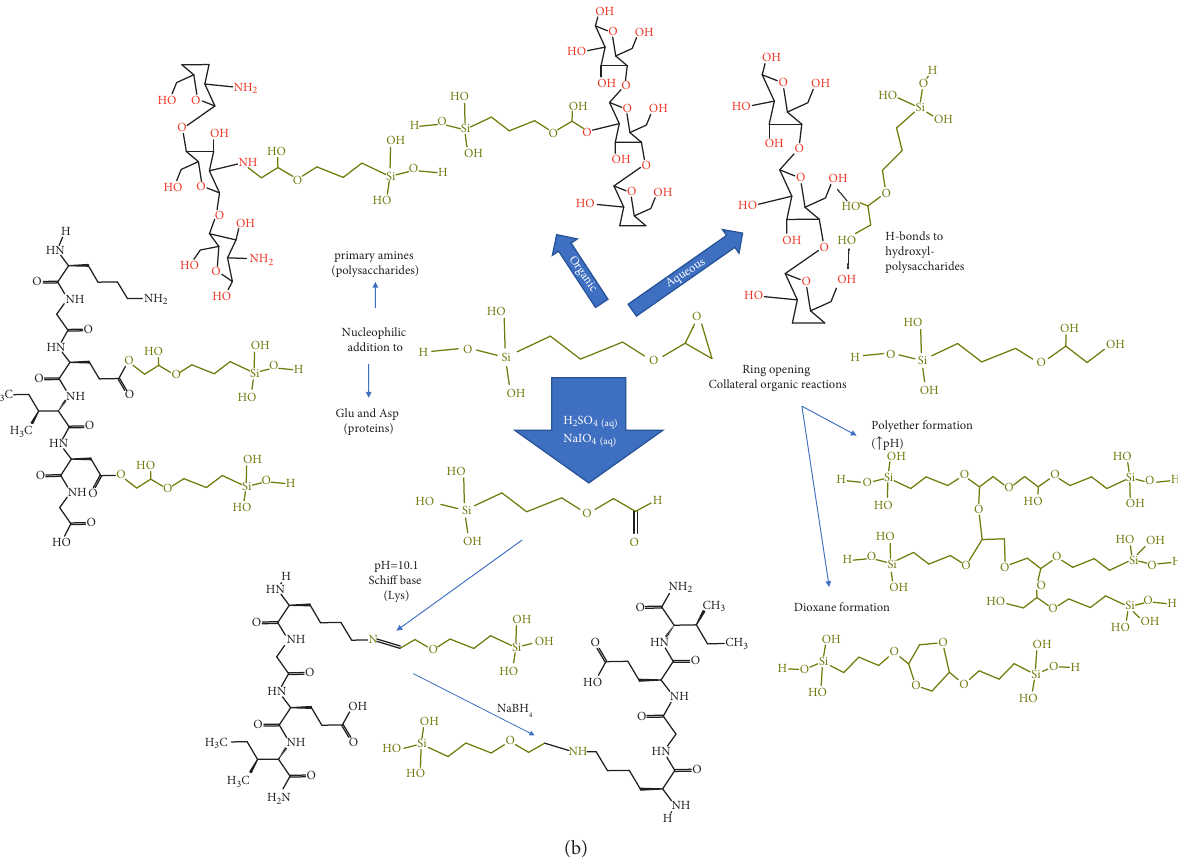
Figure 5: Multiple reactions and interaction mechanism of (a) APTES and (b) GPTMS silanes in the presence of proteins and polysaccharide hydrogel